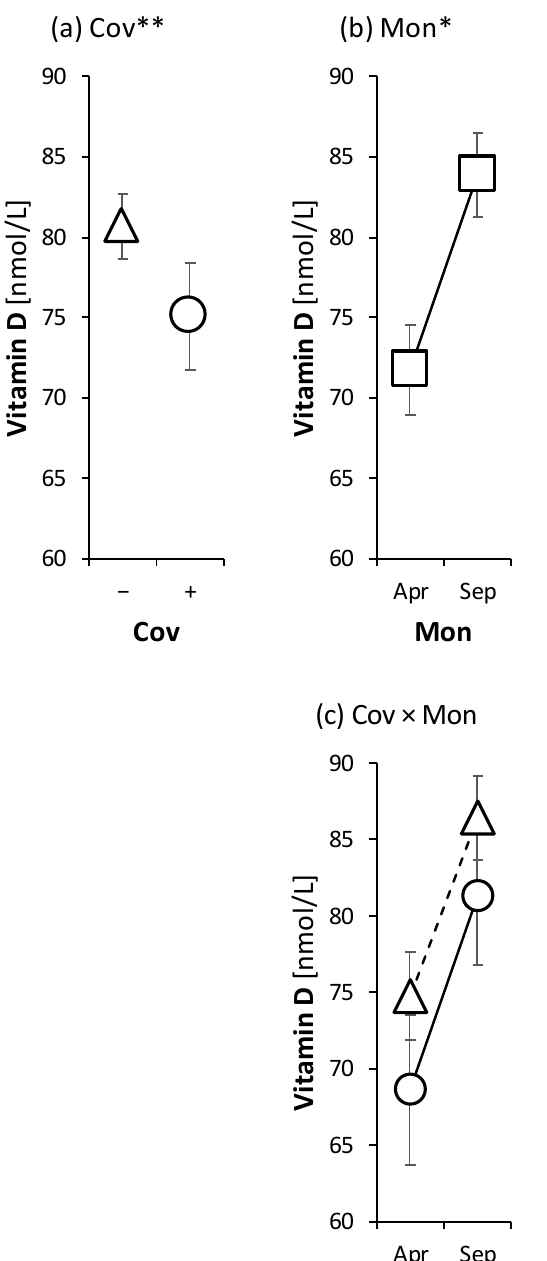
Figure 1. Analysis of relationships between levels of vitamin D and ( a ) the occurrence of COVID-19; ( b ) stage of the trial (month); ( c ) relationships in the interaction of the variables using an ANOVA model. The symbols with error bars represent retransformed means with their 95% confidence intervals. Circles and triangles represent patients with and without occurrence of COVID-19, respectively, (* p < 0.05, ** p < 0.01, *** p < 0.001). Coronavirus disease 2019, Cov, COVID-19; Mon, month; Analysis of variance, ANOVA.